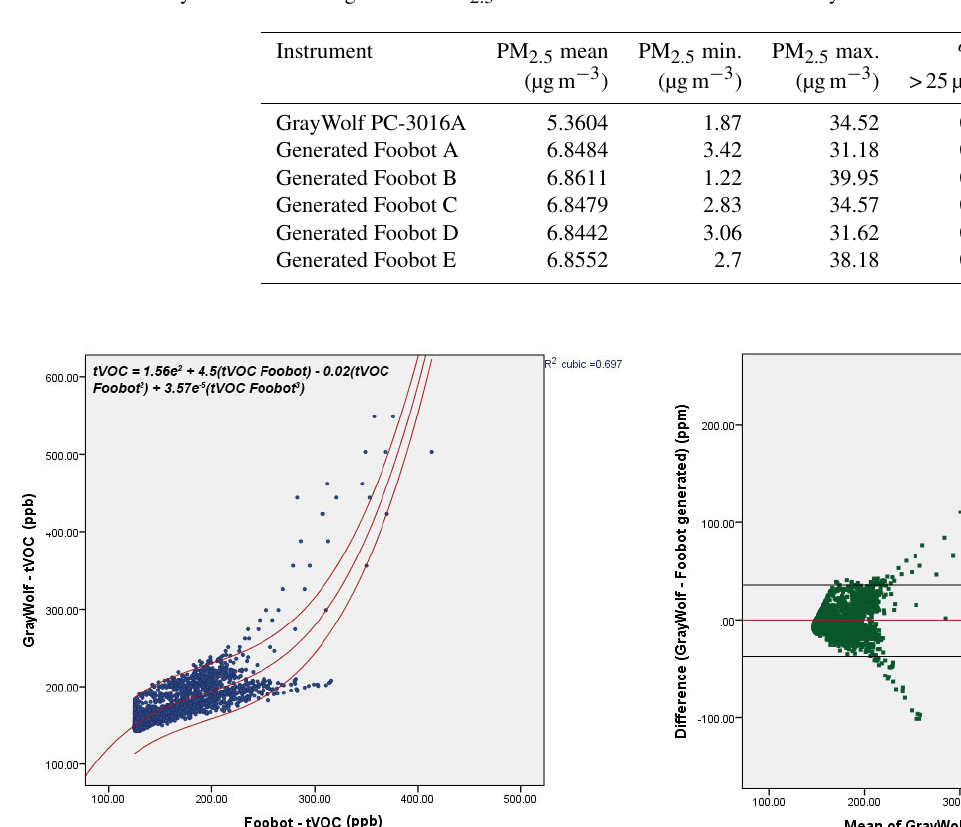
Table 8. Summary statistics for the generated PM 2 . 5 from the validation dataset divided by instruments.